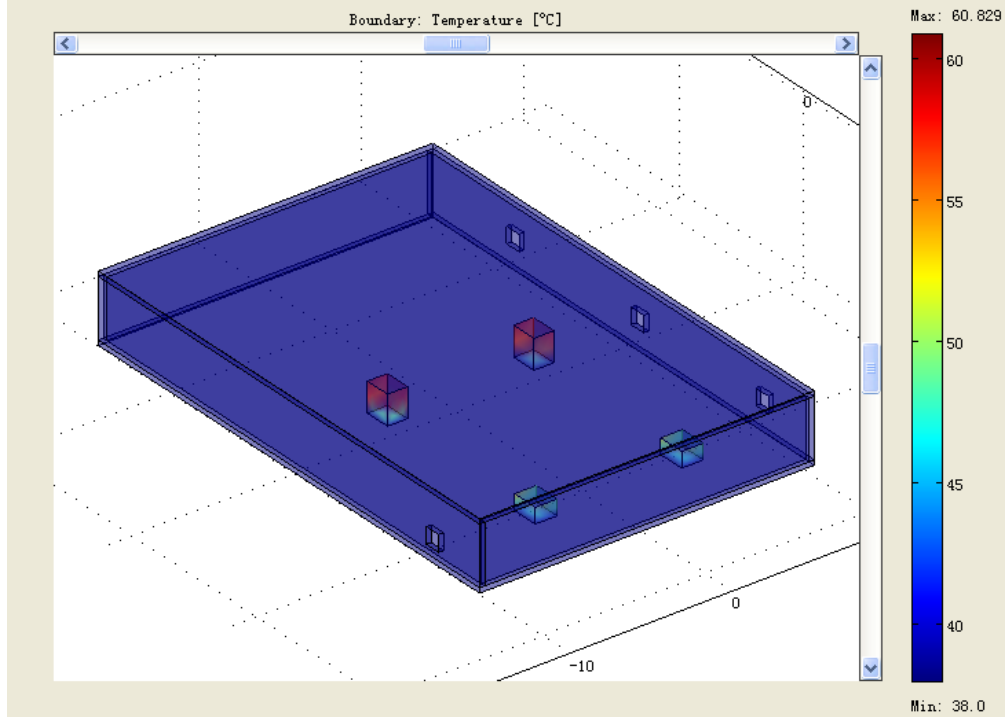
Figure 2. Temperature field distribution in the studied